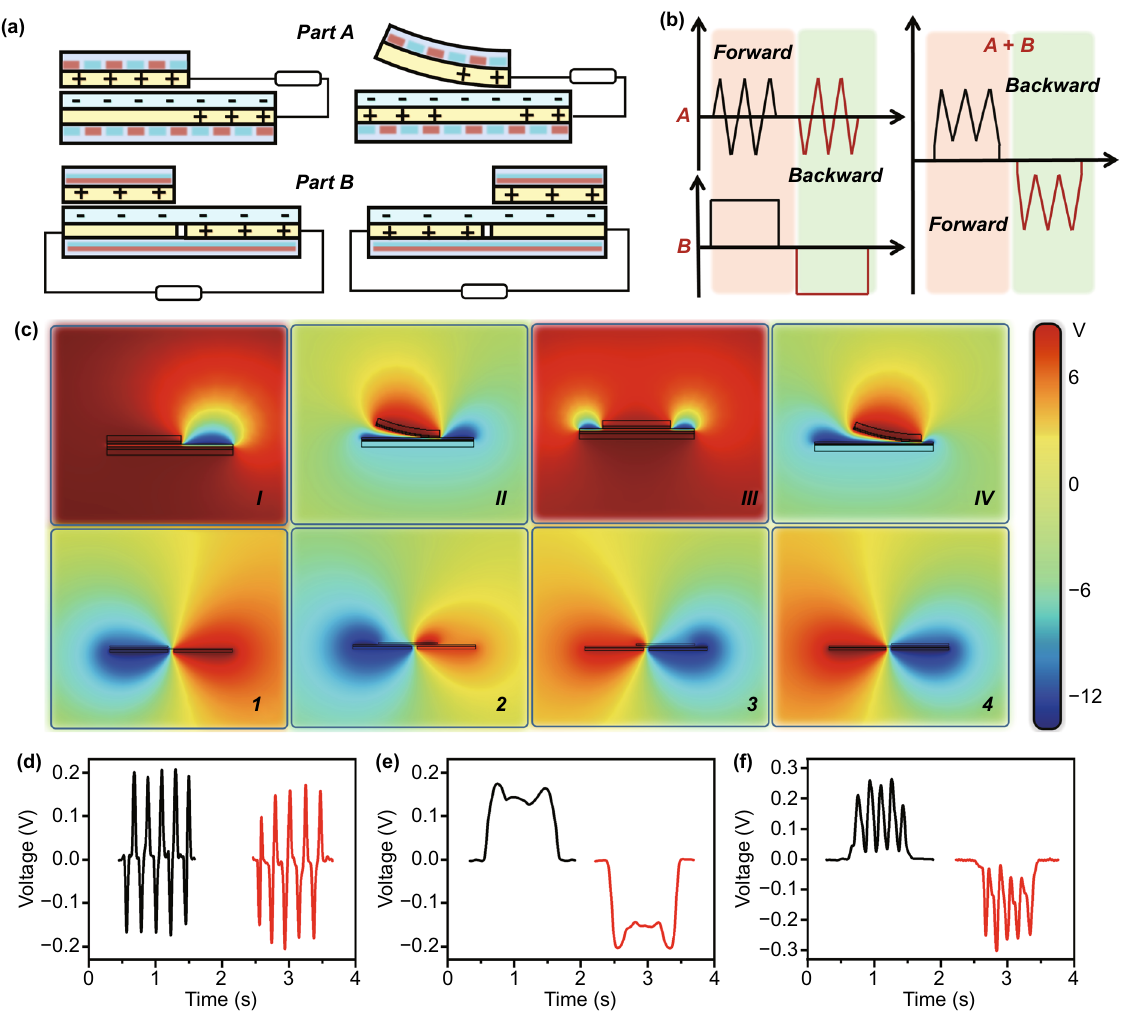
Fig. 2 Operating-principle of the Ma-s-TS. a Schematics of electron transfer process in the sliding. b Schematics of output signal in sliding process. c COSMOL simulation of potential distribution under various states in sliding process. d–f Test output signal corresponding to Fig.